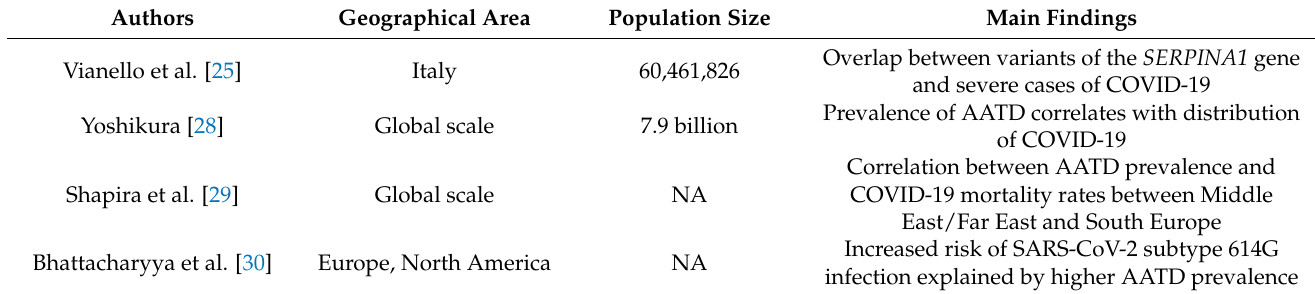
Table 1. Main results from epidemiologic studies on the overlap between α 1-antitrypsin deficiency and SARS-CoV-2 infection (NA = not